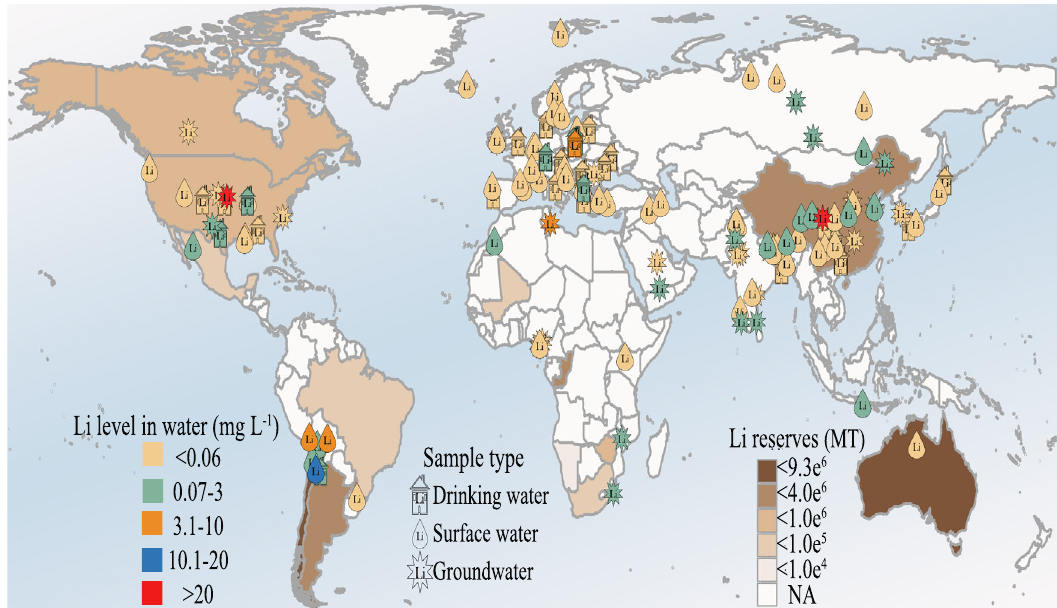
Fig. 4 Global geographical distribution of Li in various water bodies. Data sets were collected for 17 countries from published reports. The categorization (<0.06 – >20 mg L − 1 ) used is based of the recommendation by the United States Geological Survey (USGS). Three types of datasets (Li level in water (<0.06, 0.07-3, 3.1-10, 10.1-20, and >20), Sample type (drinking water, surface water, and groundwater), and Li reserves in the world) are presented. Surface water includes lakes, rivers, ponds, and glaciers. Different colors inside the icons highlight the